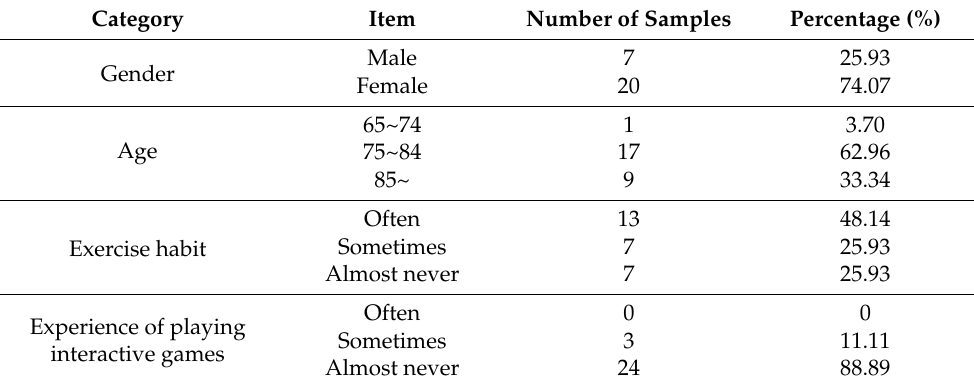
Table 5. Statistics of the backgrounds of the elderly users in the second field experiment.